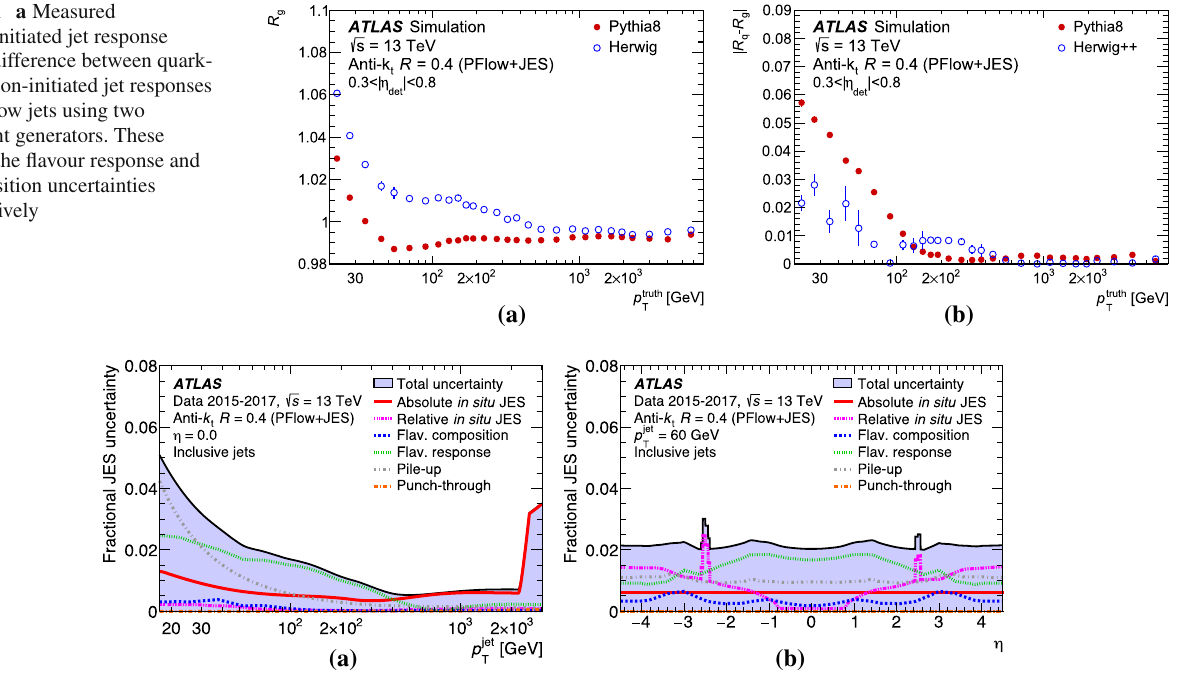
Fig. 22 Fractional jet energy scale systematic uncertainty components foranti- k t R = 0 . 4jets a asafunctionofjet p T at η = 0 and b asafunc- tion of η at p T = 60 GeV, reconstructed from particle-flow objects. The